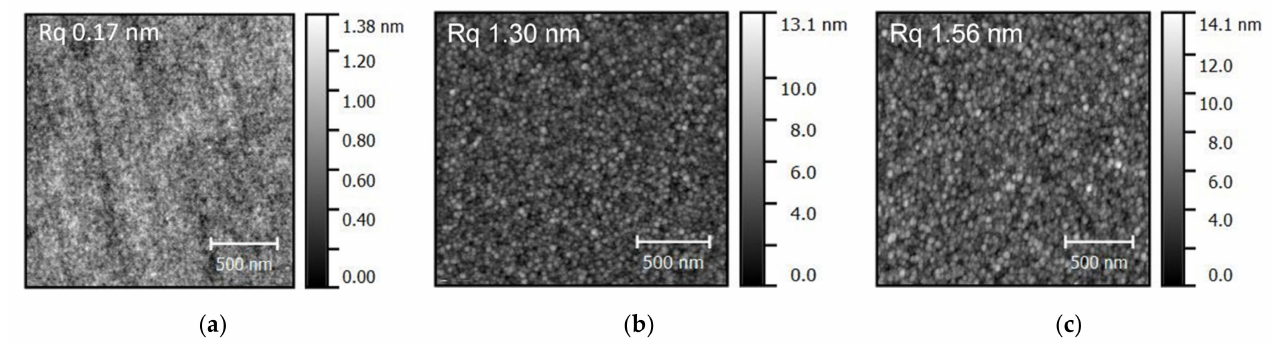
Figure A2. Characteristic AFM images (including RMS (R q ) roughness numbers) of boron thin films realized by ( a ) magnetron sputtering, ( b ) non-plasma CVD, ( c ) remote plasma